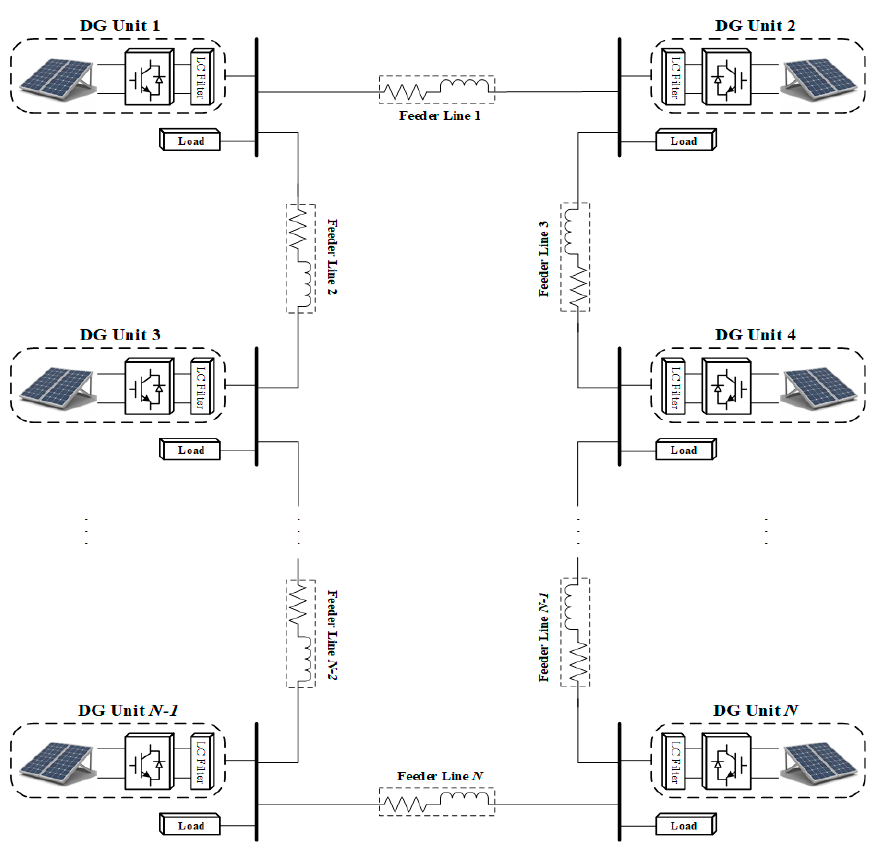
Figure 1. Modeling of an AC electrical network of islanded microgrid.